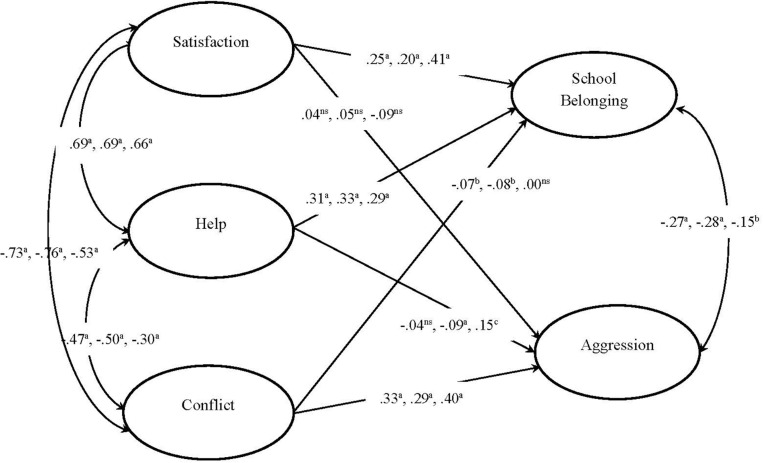
Structural equation model. Latent constructs are shown in ellipses. The standardized coefficients of all paths from left to right represent the entire, pass, and fail samples, respectively, a = p < 0.001; b = p < 0.01; c = p < 0.05; ns = non-significant.